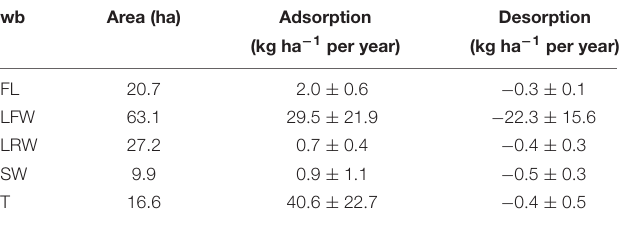
connectivity showed much higher potential for SRP adsorption if the sediments were not gravel-dominated, such as in